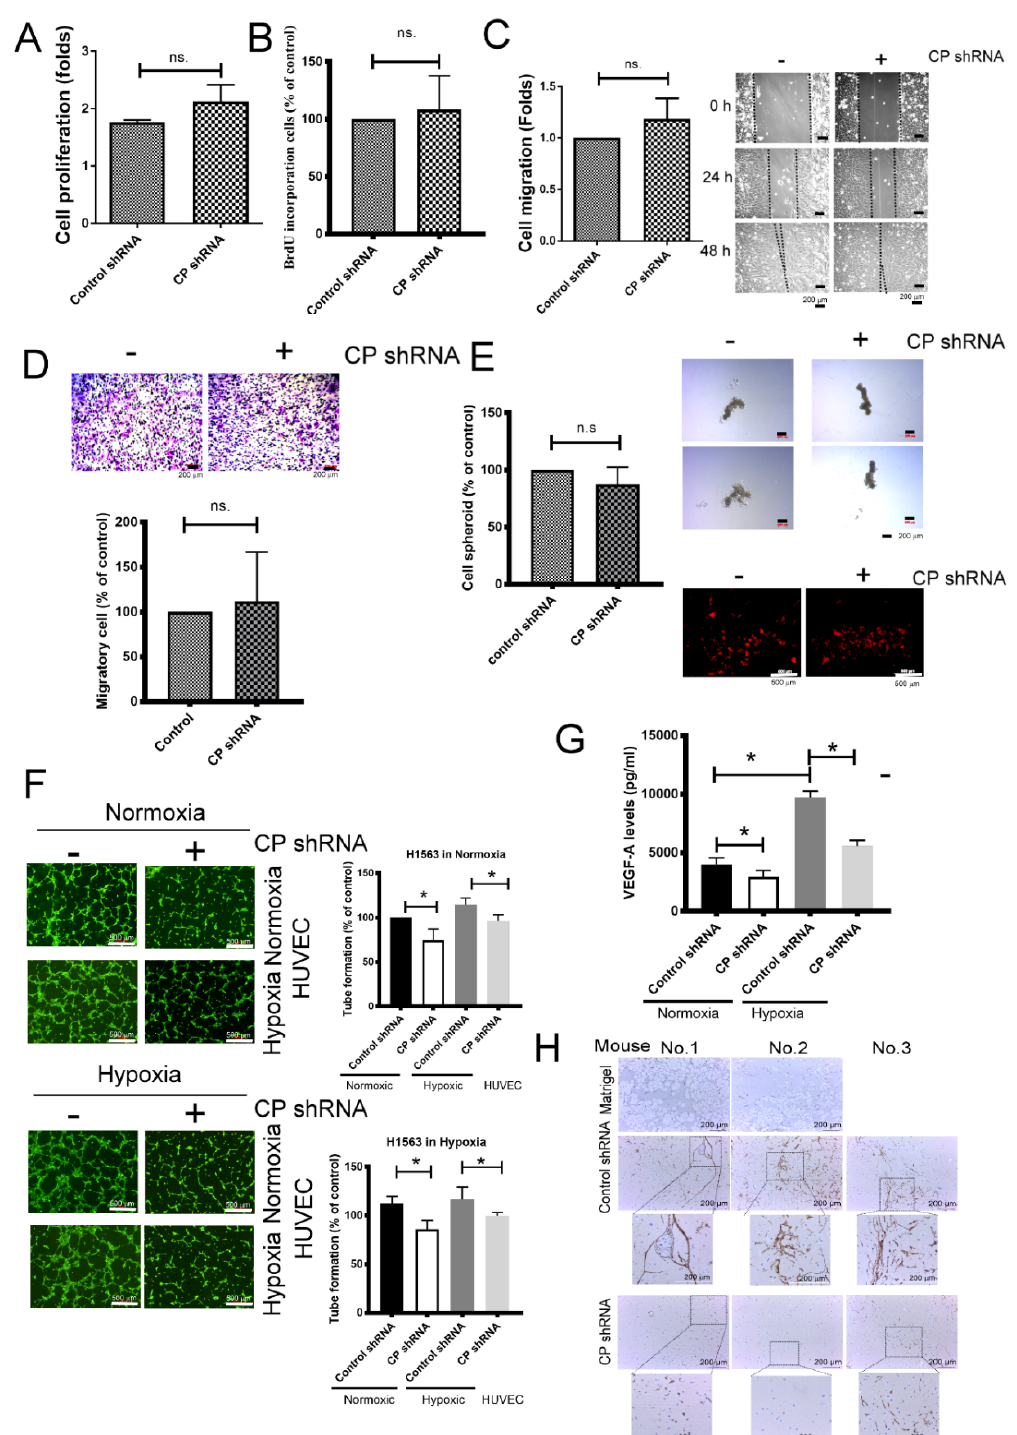
Figure 3. CP contributes to tumor angiogenesis . ( A,B ) The effect of CP in cell proliferation, as Figure3. CPcontributestotumorangiogenesis. ( A , B )Thee ff ectofCPincellproliferation, asdetermined determined by Water Soluble Tetrazolium Salts (WST-1) and Bromodeoxyuridine (BrdU) by Water Soluble Tetrazolium Salts (WST-1) and Bromodeoxyuridine (BrdU) incorporation. ( C , D ) The incorporation. ( C,D ) The influence of CP inhibition on cell migration, as determined by wound influence of CP inhibition on cell migration, as determined by wound healing and transwell system. healing and transwell system. ( E ) Inhibition of CP did not affect anchorage-independent cell growth ( E ) Inhibition of CP did not a ff ect anchorage-independent cell growth of H1563 cells. ( F ) Decreased of H1563 cells. ( F ) Decreased CP reduced tube formation in either a normoxic or hypoxic condition. CP reduced tube formation in either a normoxic or hypoxic condition. ( G ) Inhibition of CP reduced ( G ) Inhibition of CP reduced vascular endothelial growth factor-A (VEGF-A) production. ( H ) vascular endothelial growth factor-A (VEGF-A) production. ( H ) Knockdown CP reduced Knockdown CP reduced angiogenesis in a mouse model. The proliferation of H1563 and CP- knockdown H1563 were measured by WST-1 and BrdU incorporation after 72 h incubation. Cells were seeded in the top of transwell insert (8 μ m), and complete culture medium was added into the bottom well as chemoattractant for 48 h. The migratory cells were stained by crystal violet. Cells were